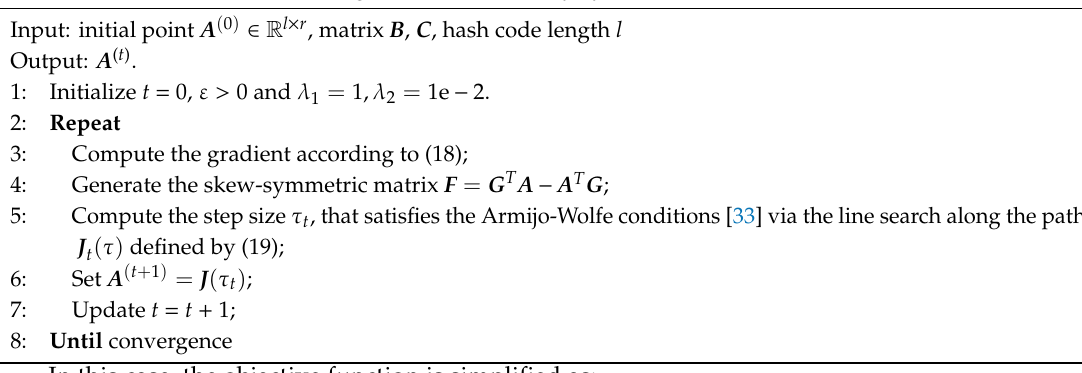
Algorithm 1 Curvilinear Search Algorithm Based on Cayley